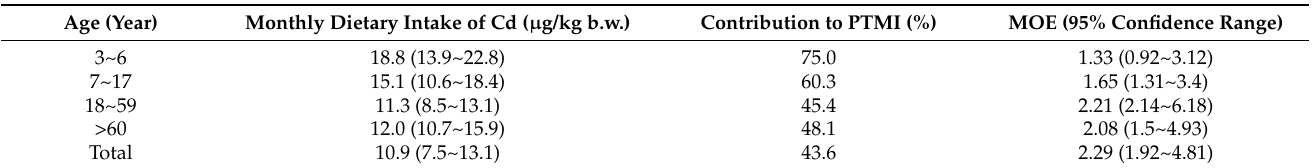
Table 3. MOE-based risk characterization of dietary Cd exposure in Guangzhou residents at varying ages. Age (Year) Monthly Dietary Intake of Cd ( µ g/kg